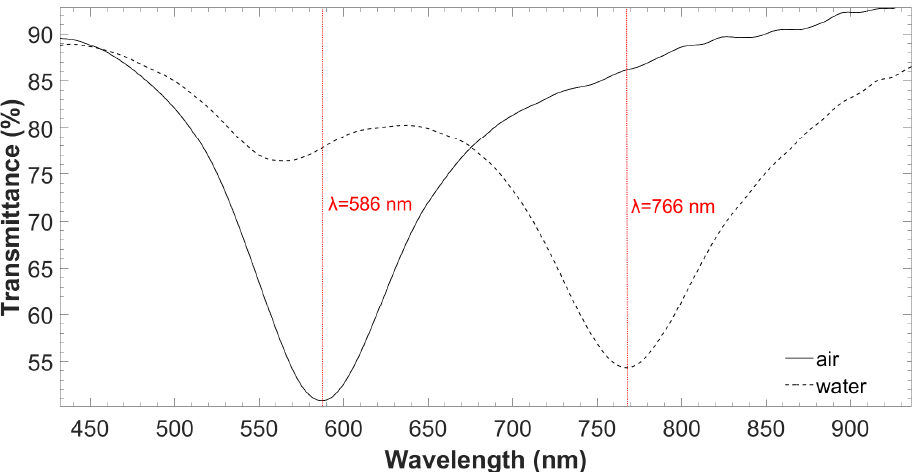
Figure 6. Experimental optical spectrum in the air and water of the generated LMR by the ALD